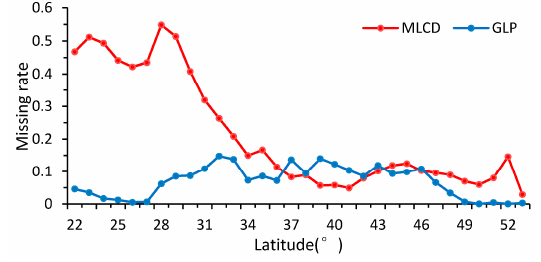
Figure 5. Missing ratios in different latitudinal bands.